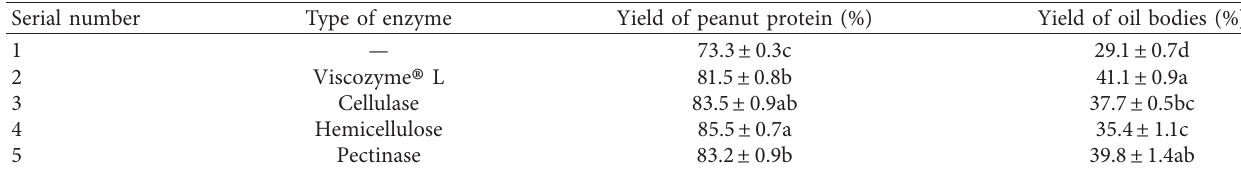
Figure 4: Microscopy of oil bodies extracted by various enzymes: (a) Viscozyme ® L; (b) cellulase; (c) hemicellulase; (d) pectinase. All photos are at the same magnification. Bar represents 10 μ m. Table 2: Effects of various enzymes on yield of peanut protein and oil